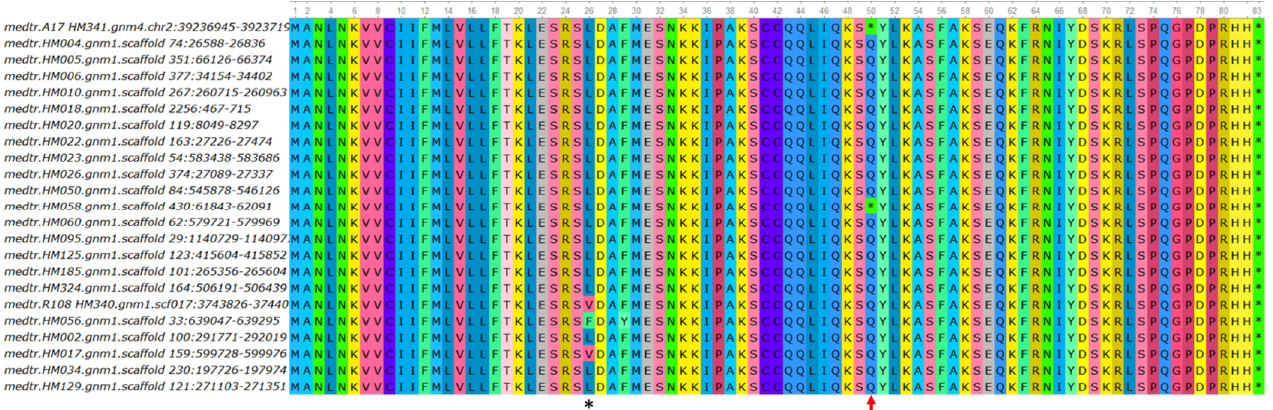
Figure 2. The sequence of the MtCLE34 gene in Jemalong A17. Stop codon is marked with a red box. CLE domain-coding region is marked with a yellow rectangle.